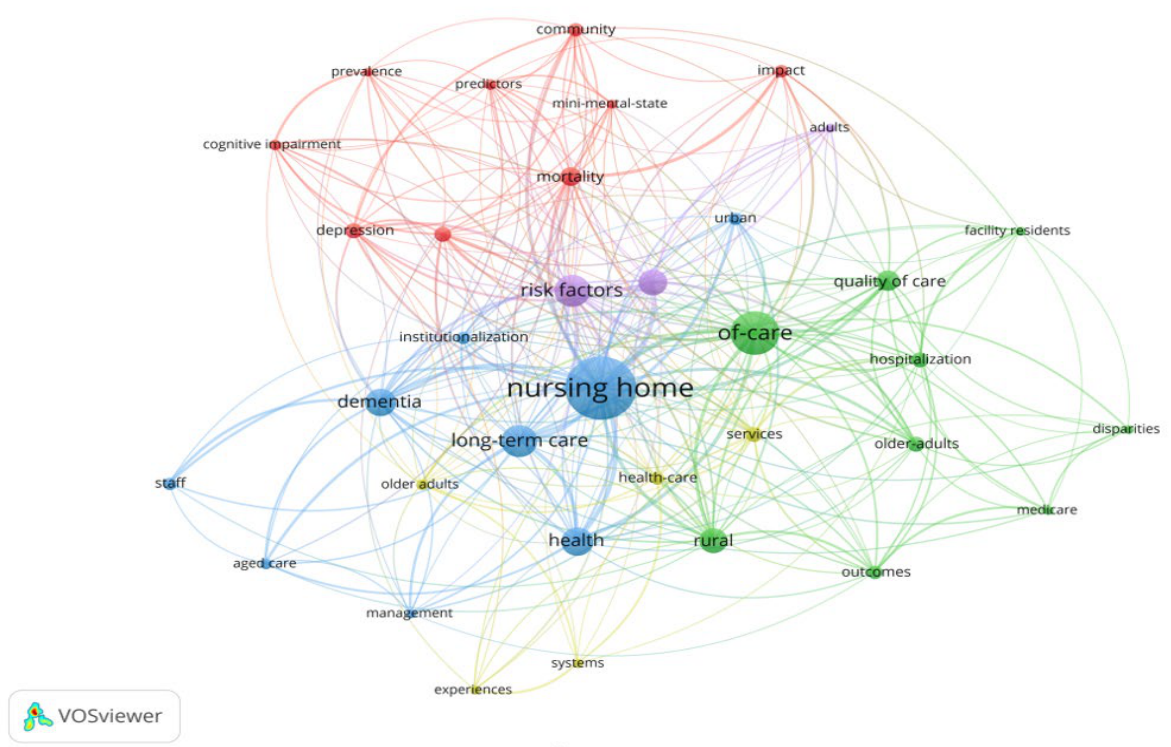
Figure 8. Map of co-occurrence of keywords in the rural institutional elder care research.